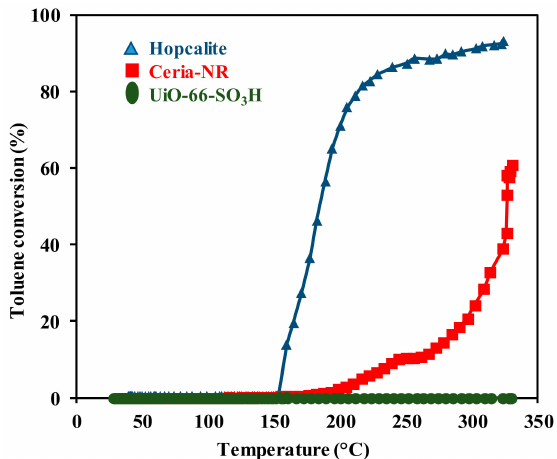
Figure 5. Light-o ff curves obtained in the presence of Hopcalite, Ceria-NR and UiO-66-SO 3 H for toluene